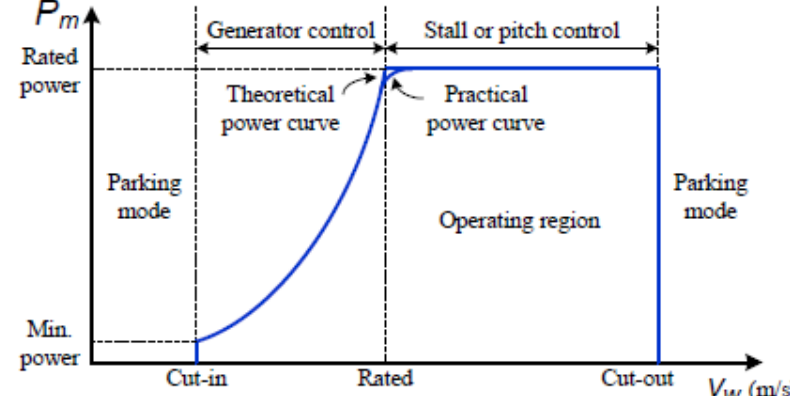
Figure 1. Wind turbine performance in different